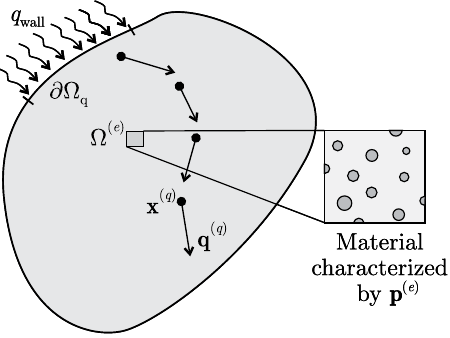
Figure 1. Heat flux manipulation problem in the domain Ω where the effective properties at each sub-domain Ω ( e ) depend on a set of parameters p ( e )